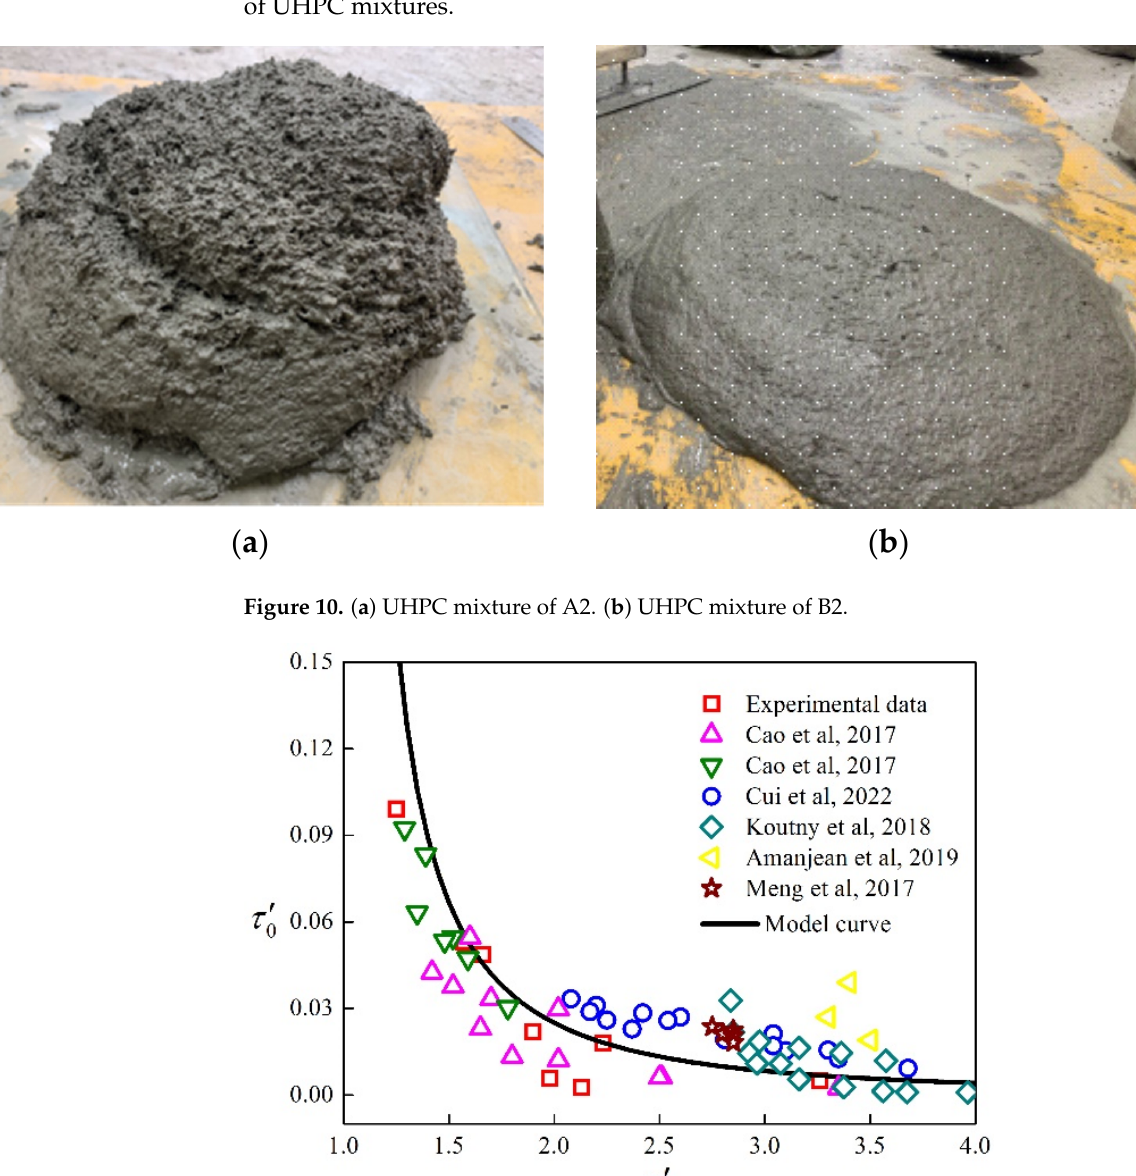
Figure 9. Relation between slump flow and yield stress of UHPC mixture.